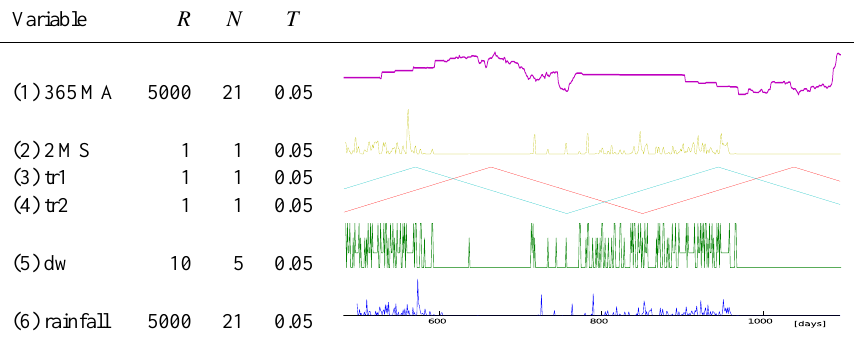
Table 2. Standard setup proposed for rainfall simulation. The parameters are search window radius R , maximum number of neighbors N and distance threshold T . The variables are (1) the 365-day moving average (365MA), (2) the moving sum of the current and the previous day amounts (2MS), (3) and (4) annual seasonality triangular functions (tr1 and tr2), (5) the dry/wet sequence (dw), and (6) the daily rainfall amount as the target variable. On the right, a portion of multivariate TI is given as